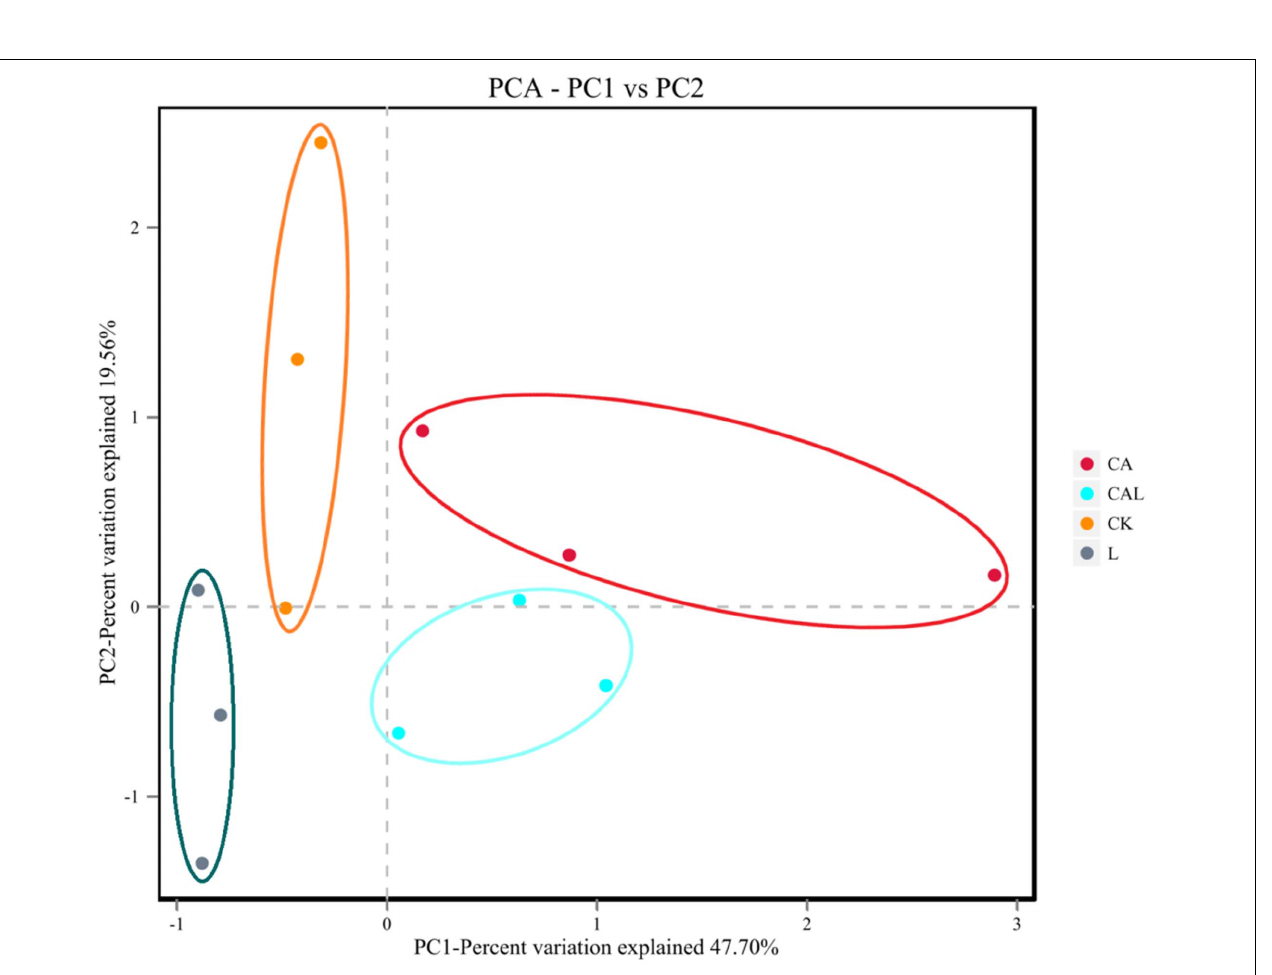
Frontiers in Microbiology |